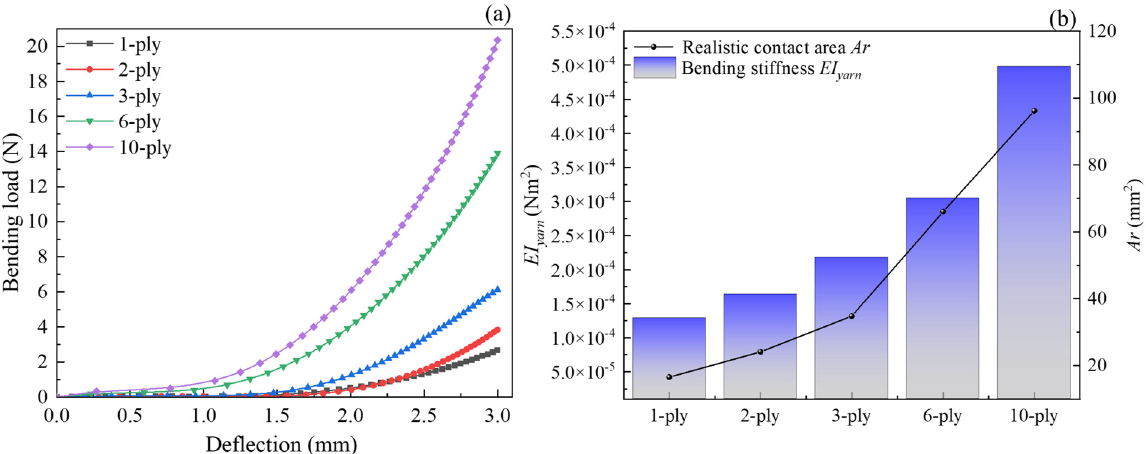
Figure 10. Prediction of bending behavior of plied yarn: ( a ) curve of deflection and bending load, ( b ) realistic contact area and bending stiffness at a deflection of 3 mm.